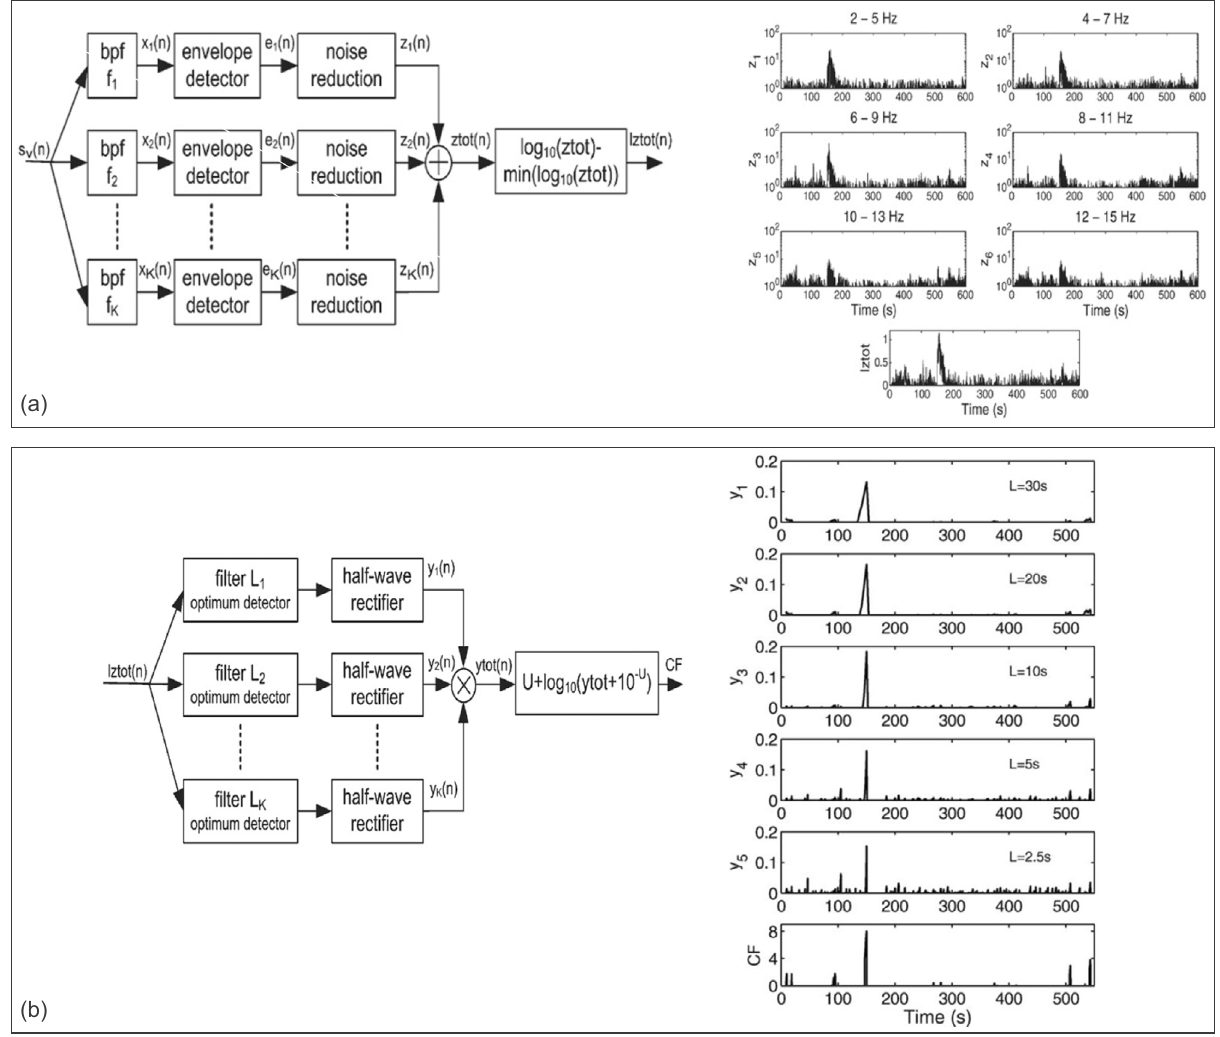
Figure 8. (a) Block diagram of the AMPA picking algorithm. Detail of the first multiband de-noising phase. (b) Block diagram of the AMPA picking algorithm. Detail of the P-arrival enhancement